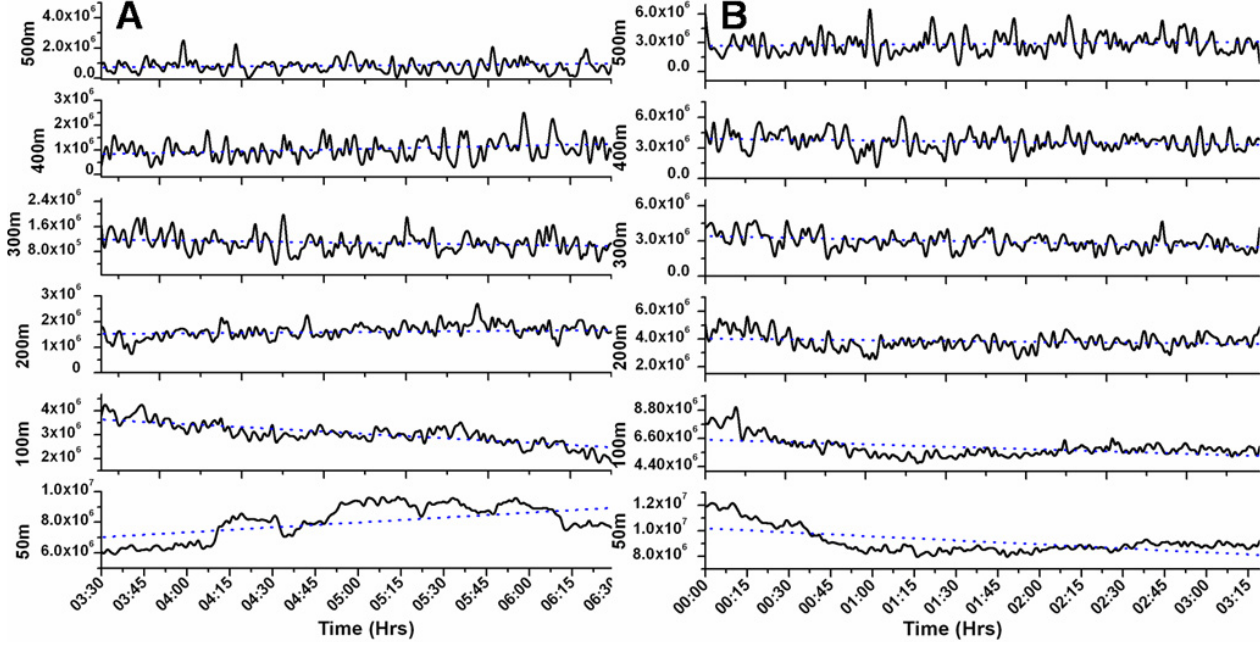
Fig. 4. Time-dependent evolution in fluctuations of lidar backscatter at discrete altitudes on (A) 14 February 2008 and (B) 24 February 2009. The blue dotted lines at all altitudes show the trend in backscatter fluctuations.